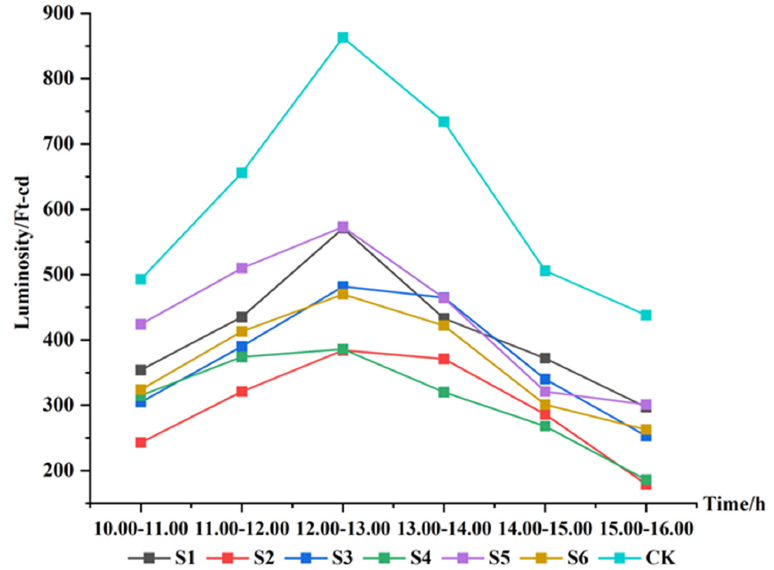
Figure 8. Luminosity diurnal variation of the tree species (S1–S6).